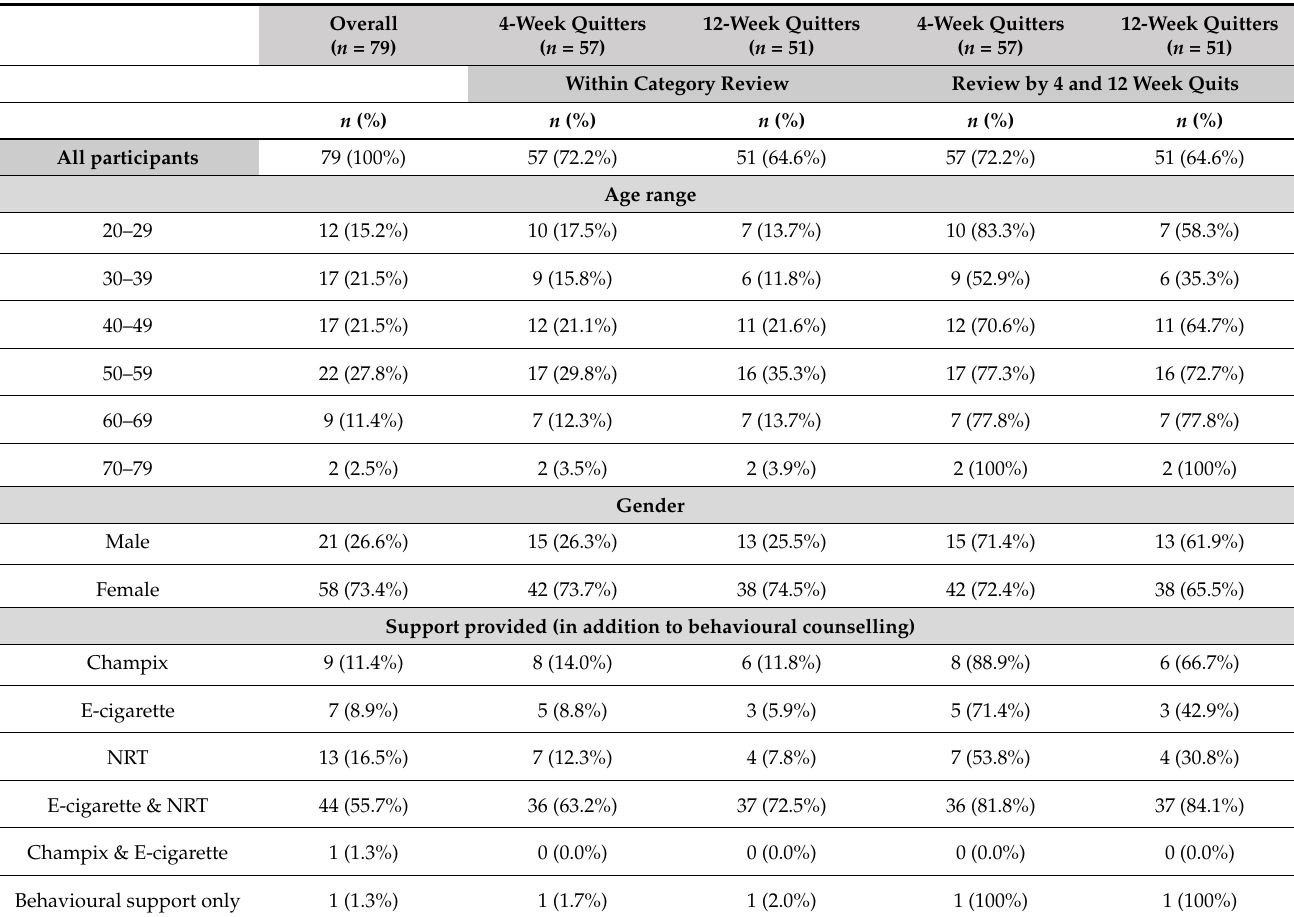
Table 1. Summary of demographic information, entry pathway, reasons for accessing the service and